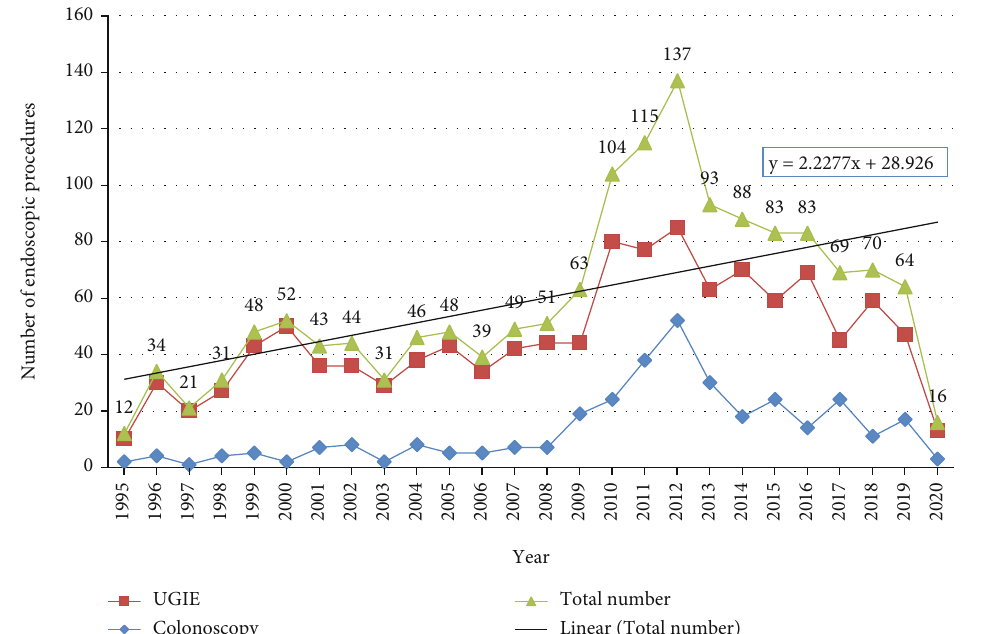
Figure 1: Number of gastrointestinal endoscopic procedures in children per year at Salmaniya Medical Complex, Bahrain (1995-2020), ( n = 1534 ). UGIE: upper gastrointestinal endoscopy.